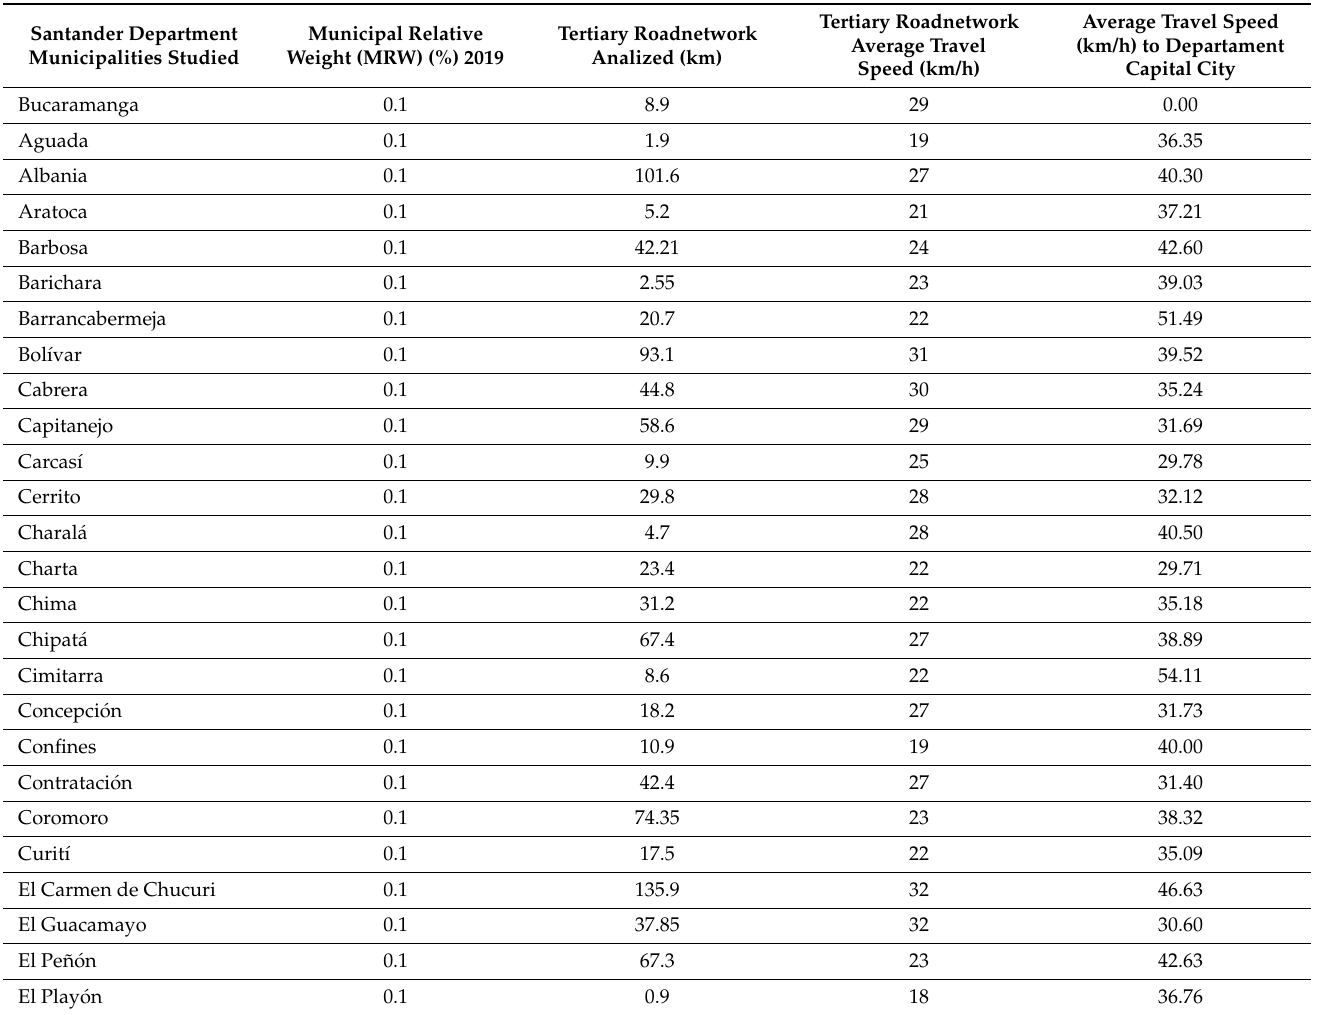
Table A4. Santander department municipalities studied information: MRW, tertiary road network length, and average travel